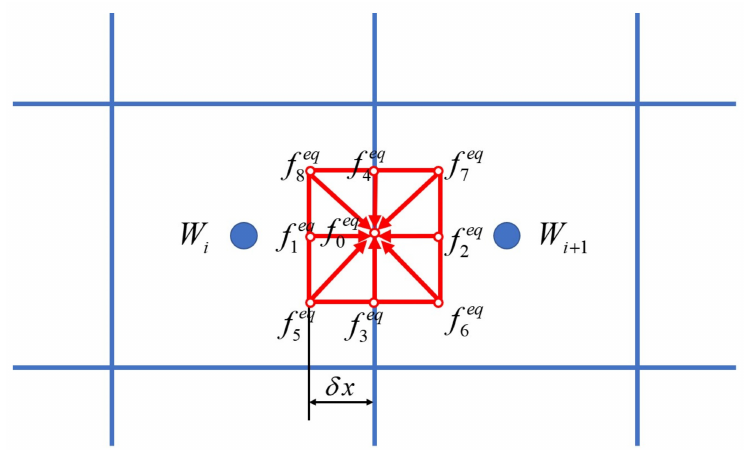
Figure 3. Illustration of the flux evaluation at cell